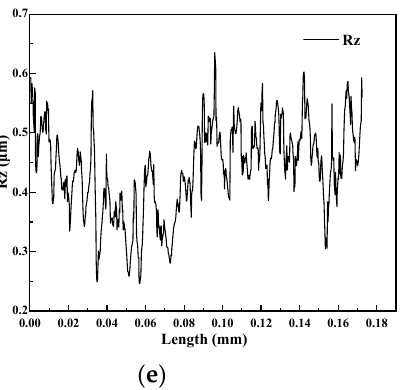
Figure 3. White light interference observation on the inner surface of after rolled pipe. ( a ) topography; ( b ) 3D morphology; ( c ) Ra ; ( d ) Rq ; ( e ) Rz . Surface roughness parameters ( Ra , Rq and Rz ) were extracted to quantify the change in roughening. On this basis, the relationship between the feed rate and surface roughness was established, as can be seen in Figure 4. With the increases in the feed rate, the roughness ( Ra , Rq, and Rz ) decreases gradually. When the feed rate ranges from 1 to 3 mm/stroke, the inner surface Ra of the pipe decreases from 0.285 µ m to 0.165 µ m, Rz varies from 0.746 µ m to 0.485 µ m, and Rq varies from 0.318 µ m to 0.221 µ m, the roughness of the inner surface of the pipe decreases significantly. However, as the feed rate gradually increases to 6 mm/stroke, Ra of the pipe decreases from 0.165 µ m to 0.146 µ m, Rz varies from 0.487 µ m to 0.485 µ m, and Rq varies from 0.221 µ m to 0.181 µ m, the reduction in the roughness tends to slow down. The reason may be that with the increase in the feed rate, the oil film thickness between the inner surface of the pipe and the mandrel increases. When the oil film thickness is too large, the reduction in the inner wall thickness will be affected [8–10], and the reduction trend of the roughness will slow down.